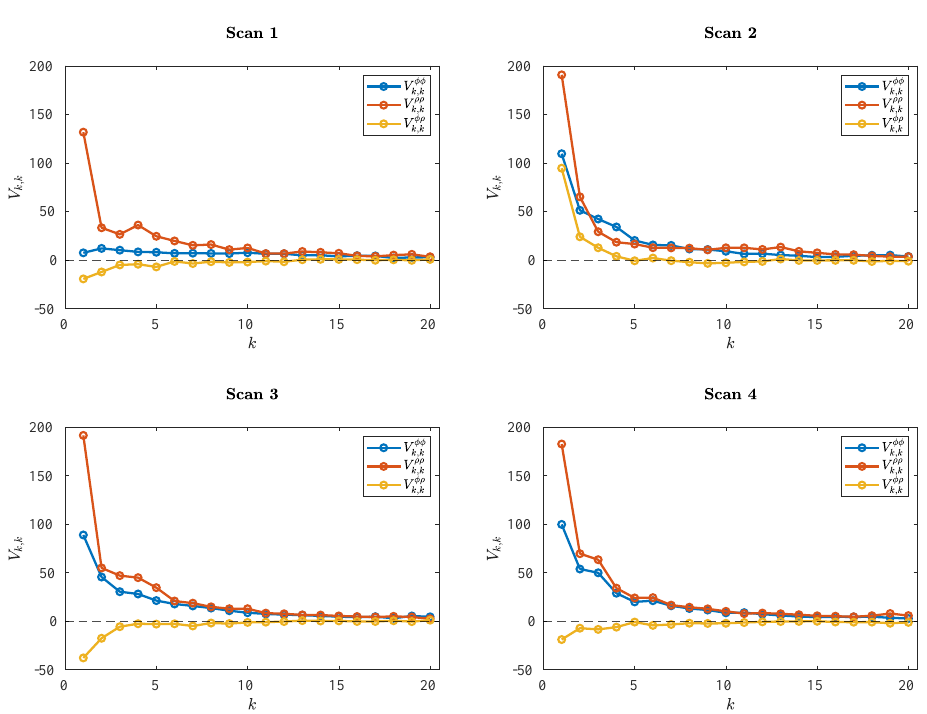
Figure 9: The tomographically reconstructed diagonal quadrature moments con- firm the dominance of density over phase initial correlations in the experiment: The plots show the correlations V φρ = 1 〈 ˆ φ δ ˆ ρ 〉 as functions of the mode number k in the initial state of each V k k 2 k , k of the four scans, as reconstructed by means of the tomographic recovery of second moments of quadratures. We observe that in all scans, V of 2 in the lowest modes, and also V in most